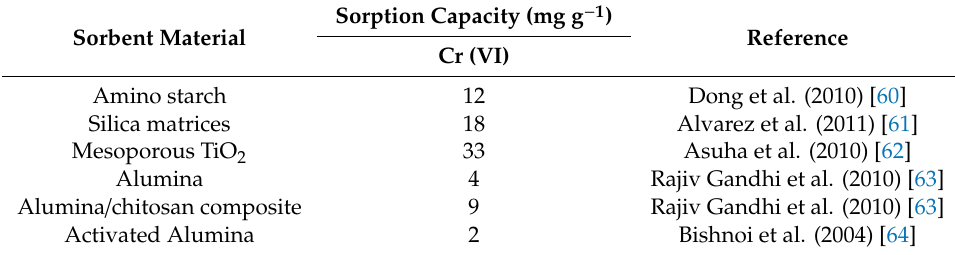
Table 4. Comparison of the sorption capacities of various sorbents towards Cr(VI) ions. Sorbent